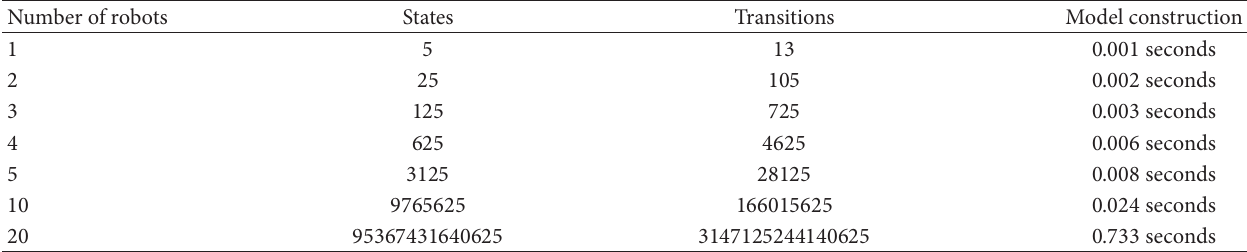
Table 3: State space for different swarm